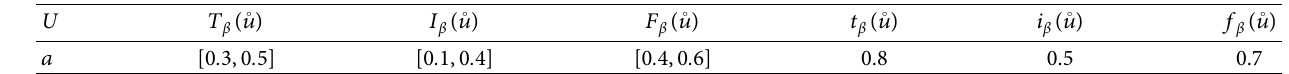
Table 5: External neutrosophic cubic set β of U.